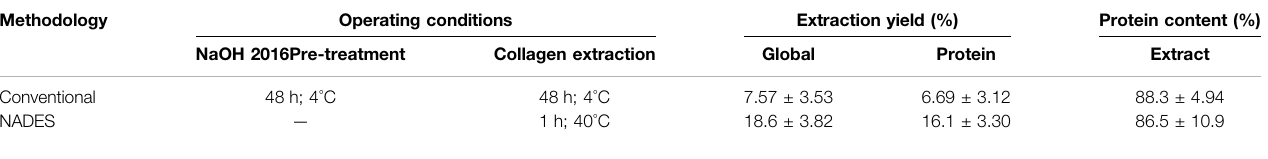
TABLE 1 | Global extraction yield (%), extracts ’ protein content (%) and the protein extraction yield (%) of the extracts obtained from blue shark skins with conventional solvent and NADES. Methodology